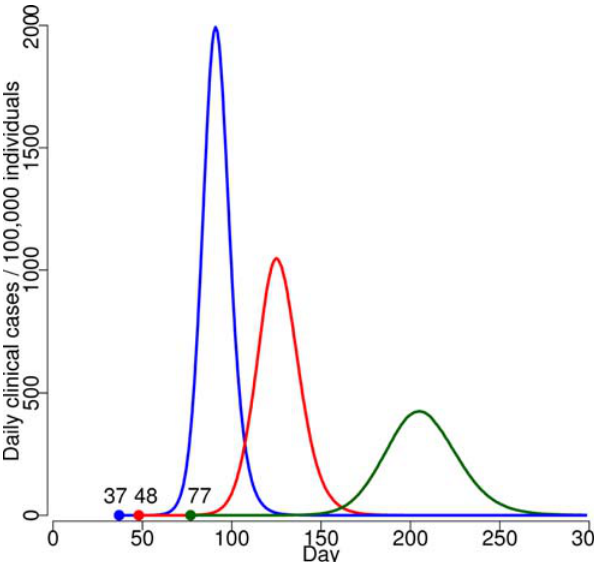
Figure 1. Baseline simulations under different R 0 scenarios (blue line: R 0 =2; red line: R 0 =1.7; green line: R 0 =1.4). Bullet points represent the first Italian case and the time elapsed from the first world case.